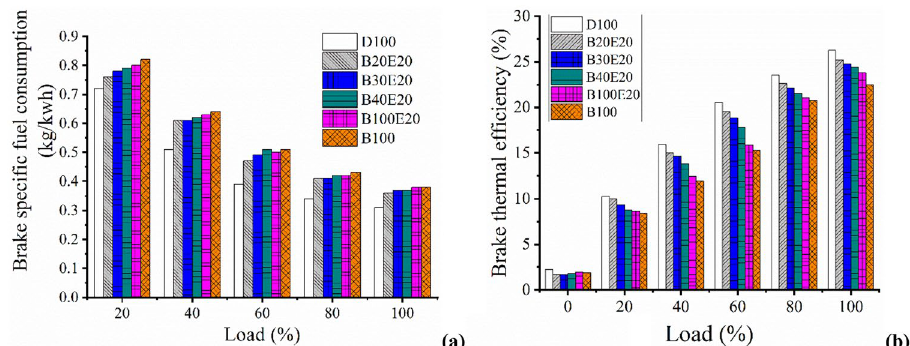
Fig. 3 Performance variations at different conditions of fuels versus engine load): a BSFC, and b BTE